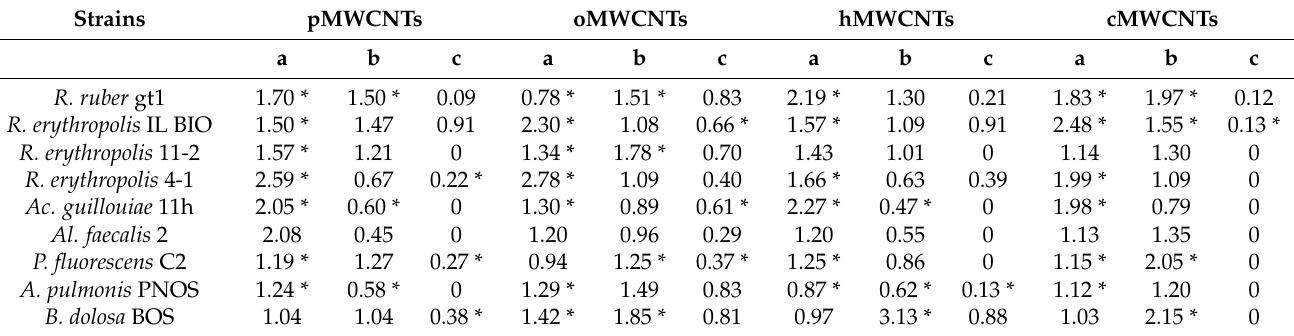
Table 1. Effects of pMWCNTs and functionalized MWCNTs on the respiratory activity of biofilms, I deg . Strains pMWCNTs oMWCNTs hMWCNTs cMWCNTs